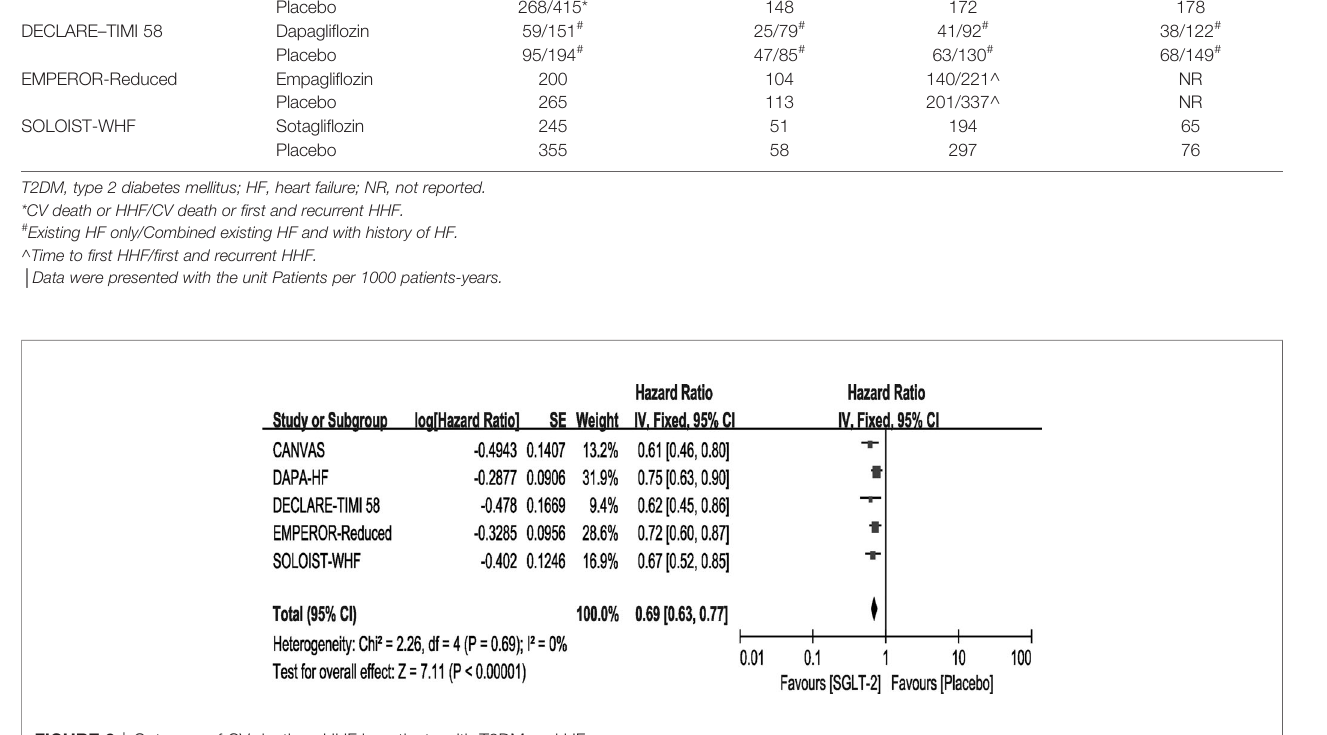
FIGURE 2 | Outcome of CV death or HHF in patients with T2DM and HF.